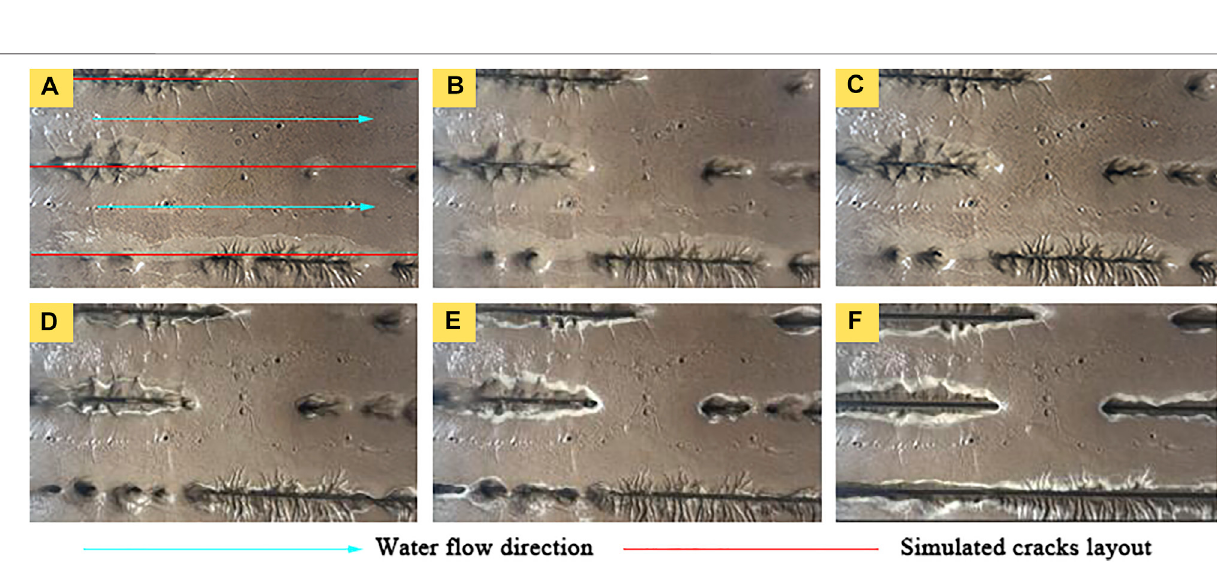
FIGURE5| Surfacecollapseprocessunderloesserosion. (A) Afterthe fi rstwaterreserve – dischargecycle; (B) afterthreewaterreserve – dischargecycles; (C) after fi ve water reserve – discharge cycles; (D) after seven water reserve – discharge cycles; (E) after ten water reserve – discharge cycles; (F) and after thirteen water reserve – discharge